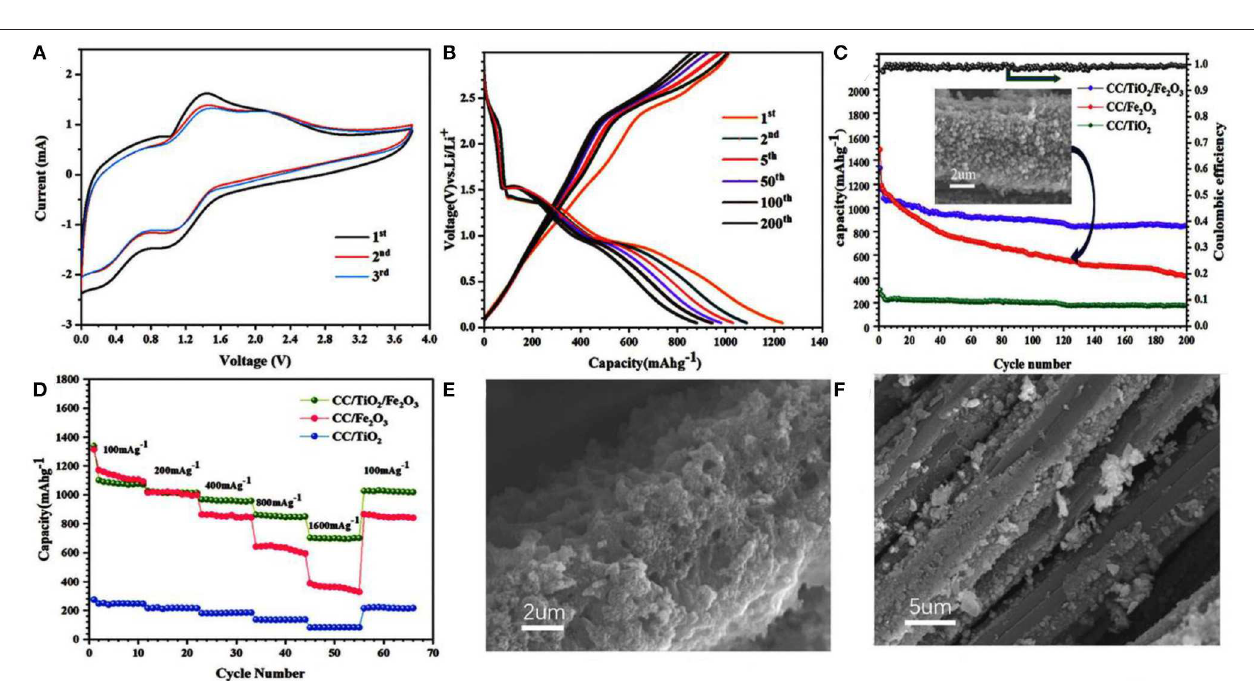
FIGURE 4 | (A) CV curves of CC/TiO 2 /Fe 2 O 3 specimens between 5mV and 3.8V at a scan rate of 0.5 mVs − 1 . (B) Charge-discharge voltage profiles of CC/TiO 2 /Fe 2 O 3 specimens at a constant current rate of 200 mAg − 1 . (C) Cycling performances of CC/TiO 2 /Fe 2 O 3 , CC/TiO 2 , and CC/Fe 2 O 3 specimens at a constant current rate of 200mA g − 1 . (D) Rate performances of CC/TiO 2 /Fe 2 O 3 , CC/TiO 2 , and CC/Fe 2 O 3 specimens. SEM image of (E) CC/TiO 2 /Fe 2 O 3 and (F) CC/Fe 2 O 3 specimens after 200